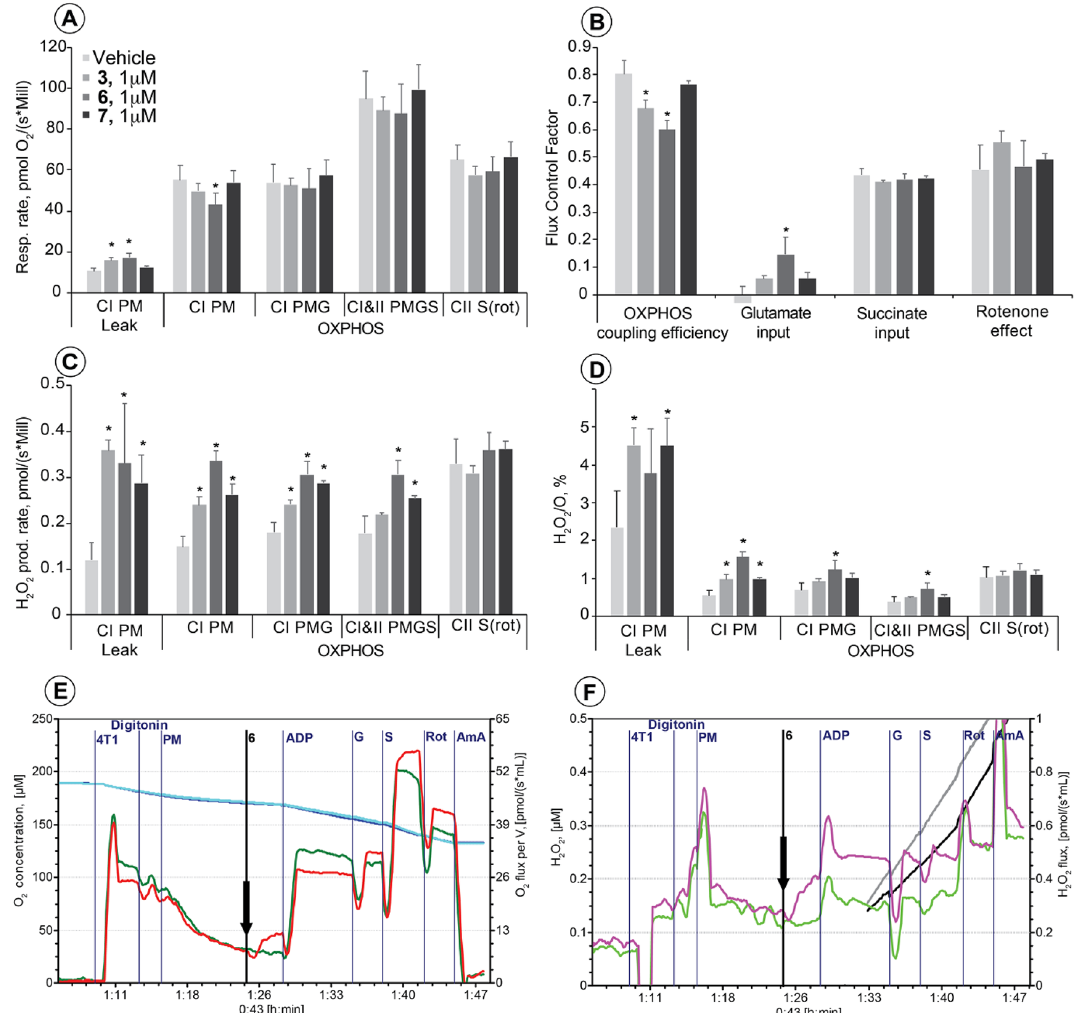
Figure 4. The effect of fused isoselenazolium salts at 1 μM concentration on mitochondrial respiration ( A ), flux control factors ( B ), H 2 O 2 production rate ( C ) and H 2 O 2 /O ratio ( D ) in permeabilized 4T1 cells. Representative traces of respiration ( E ) and H 2 O 2 production rate ( F ) measurement (vehicle—green ( E ) and light green ( F ) lines; compound 6—red ( E ) and purple ( F ) lines). CI—complex, I; CII—complex II; LEAK—substrate dependent respiration rate; OXPHOS—oxidative phosphorylation dependent state; P—pyruvate; M—malate; ADP—saturating ADP; G—glutamate; S—succinate; Rot—rotenone, AmA—antimycin A. OXPHOS coupling efficiency corresponds to 1-Respiratory Control Ratio -1 . Flux Control Factor indicates on the input of each substrate and/or pathway to the electron transfer system performance. Values are shown as mean ± S.D. (n = 3–4 experiments). Significant difference (*- p < 0.05) compared with